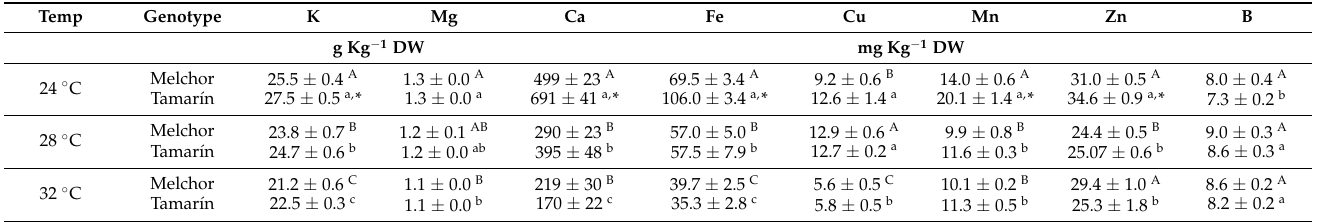
The data are presented as the treatment means ( n = 6) ± S.E. Different lowercase letters indicate significant differences between temperatures in Melchor and different uppercase letters indicate significant differences between temperatures in Tamarín. * Denotes significant differences between two cultivars grown under the same temperature conditions.